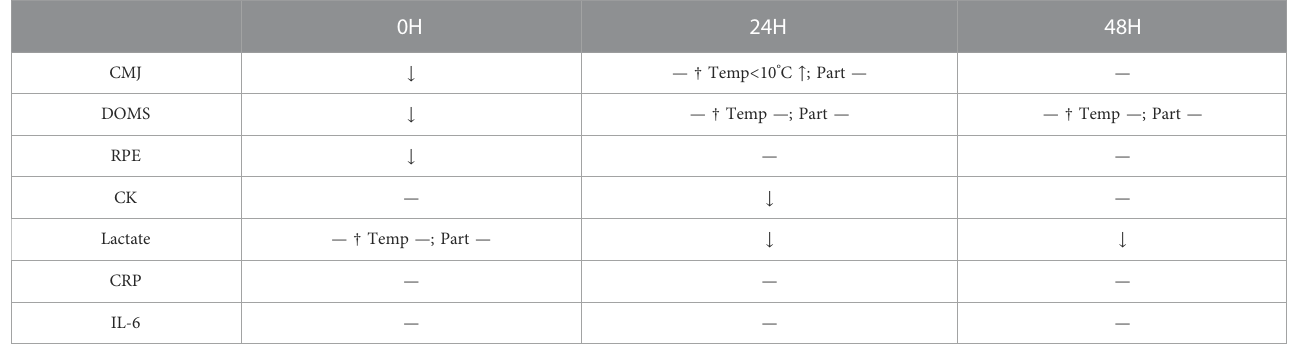
TABLE 2 Summary of